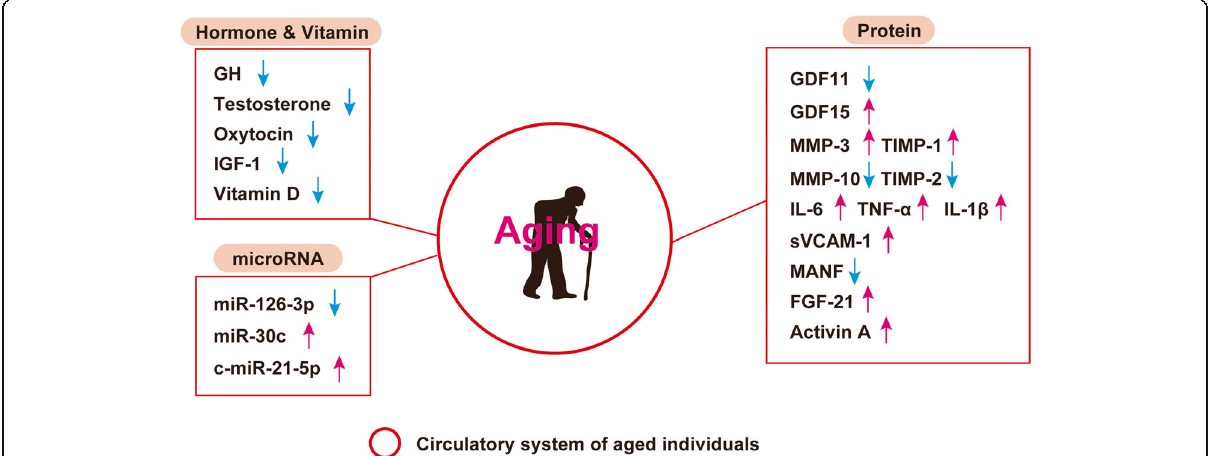
Fig. 1 Concentration of hormones, vitamins, proteins, and microRNAs changes with chronological aging, and these are described in the figure. Growth differentiation factor (GDF), matrix metalloproteinase (MMP), tissue inhibitor of metalloproteinases (TIMP), interleukin (IL), tumor necrosis factor α (TNF- α ), soluble vascular cell adhesion molecule-1(sVCAM-1), mesencephalic astrocyte-derived neurotrophic factor (MANF), fibroblast